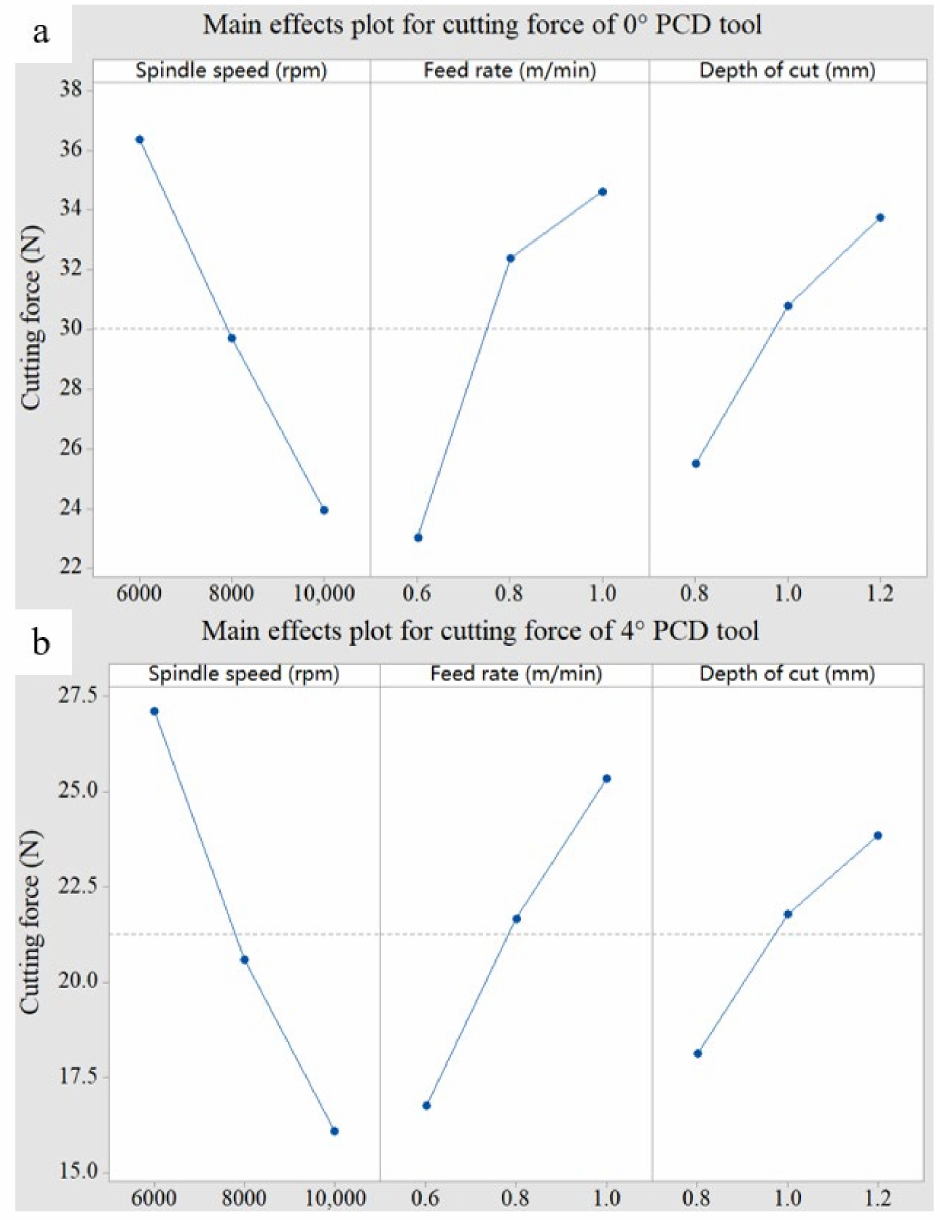
Figure 7. Main effects plot for cutting force. ( a ) 0 ◦ PCD tool; ( b ) 4 ◦ PCD